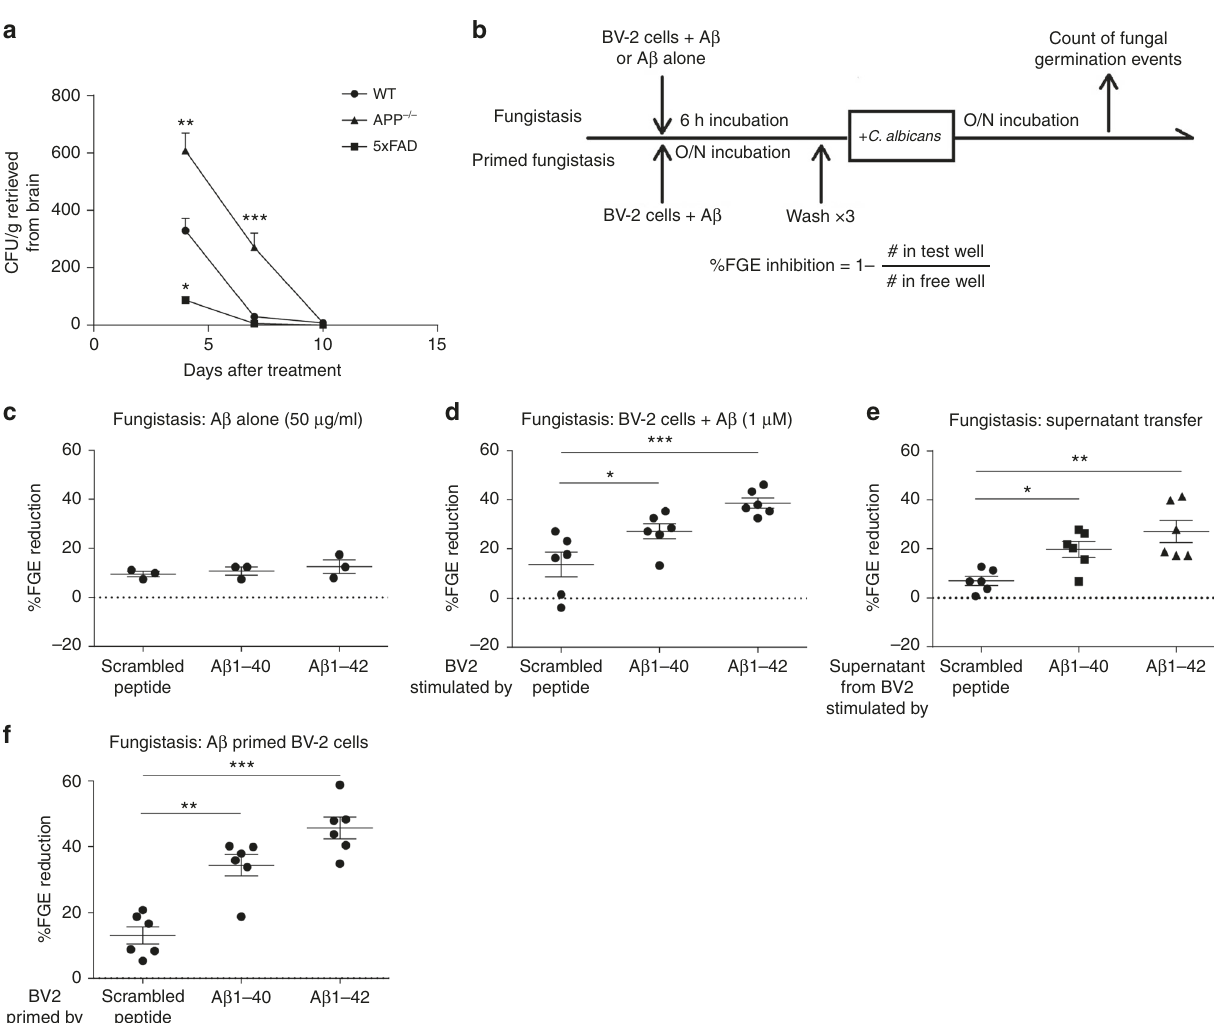
Fig. 5 Amyloid β indirectly induces fungistasis of Candida albicans . a Clearance of C. albicans from brains of wild-type, app − / − , or 5xFAD mice after i.v. challenge with 25,000 viable cells over 10 days. b Schematic of in vitro fungistasis assay. c A β peptides 40 and 42 and scrambled peptide (50 μ g/ml) were added to in vitro cultures of C. albicans (200 viable cells/ml) for 16 h and the effect on fungal growth inhibition as determined was assessed by percent fungal germination event (%FGE) inhibition. d BV-2 cells were pre-treated with the above peptides at 2 μ g/ml for 6 h and then C. albicans (200 viable cells/ml) were added. Fungal inhibition was calculated same as above. e Supernatant from the medium in which BV-2 cells were pre-treated with A β peptides ( d ) was extracted and then C. albicans (200 viable cells/ml) were added and incubated for 16 h. f BV-2 cells were primed with A β peptides overnight and then washed three times to remove soluble A β peptides before addition of yeast cells. ( n = 3 for c , n = 4 for a , n = 6 for d – f , mean ± S.E.M, * p < 0.01, ** p < 0.01, *** p < 0.001 using two-tailed Student ’ s t -test ( a ) or one-way ANOVA followed by Tukey ’ s test for multiple comparison ( b – e ). Data are shown as representative of four independent